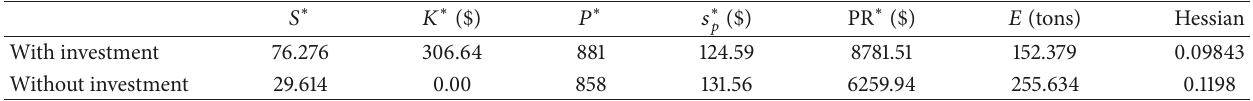
Table 3: Optimum results of profit maximization policy.